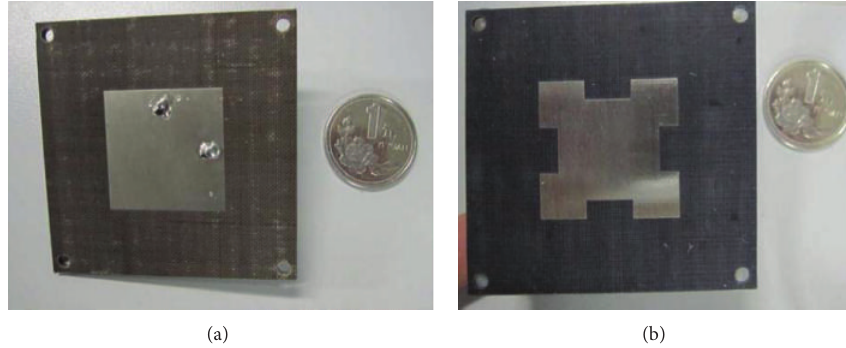
Figure 3: Photograph of the fabricated antenna. (a) Top layer. (b) Bottom layer.